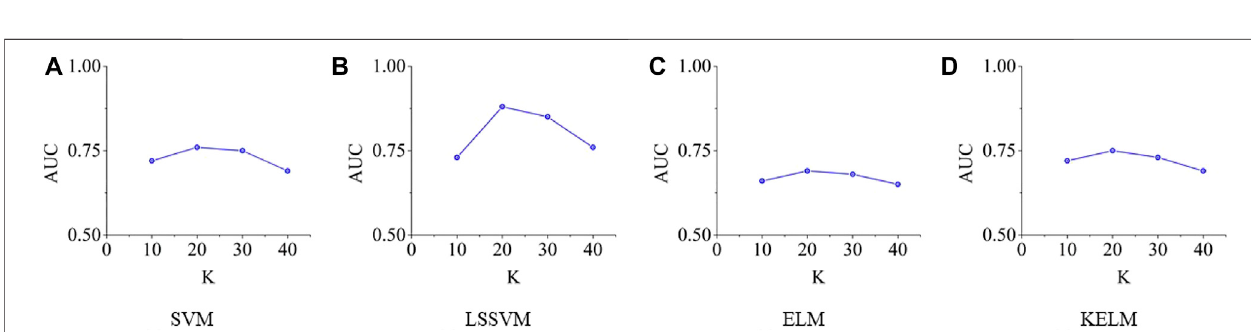
performance when K (cid:2) 20 and thus it is selected as the optimal setting for the dimension of the input EWMA vector in our study.